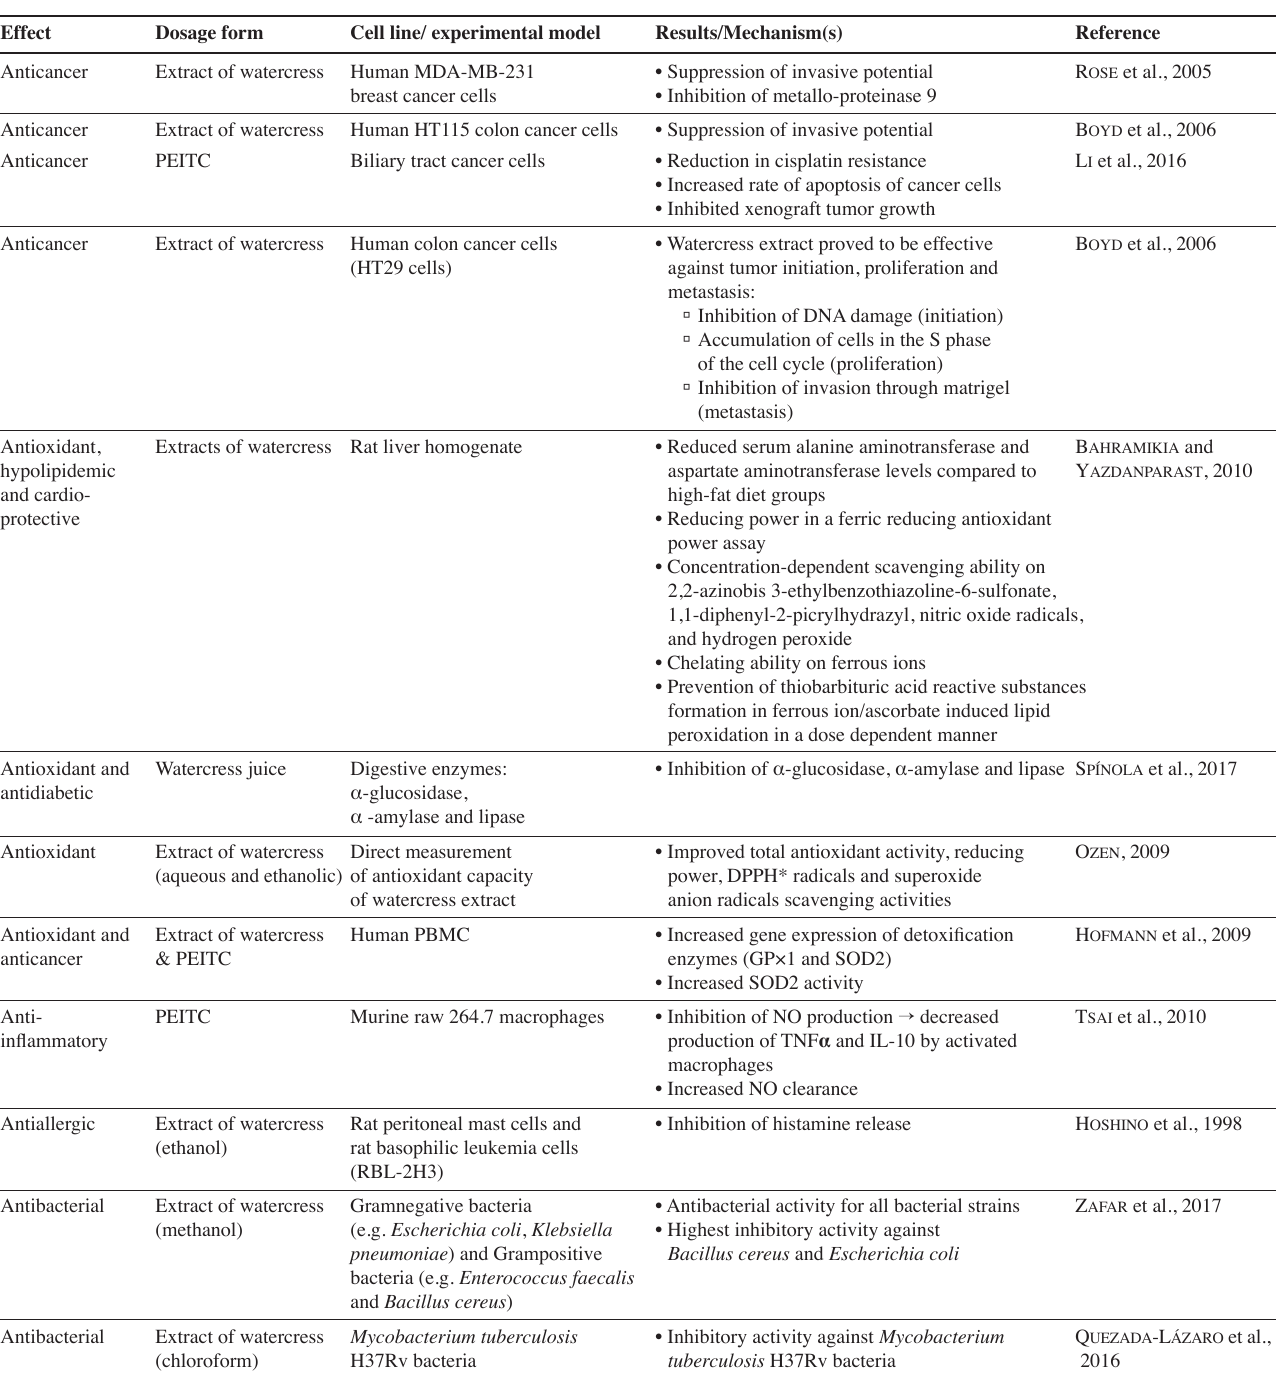
Tab. 2: Health effects of watercress – in vitro